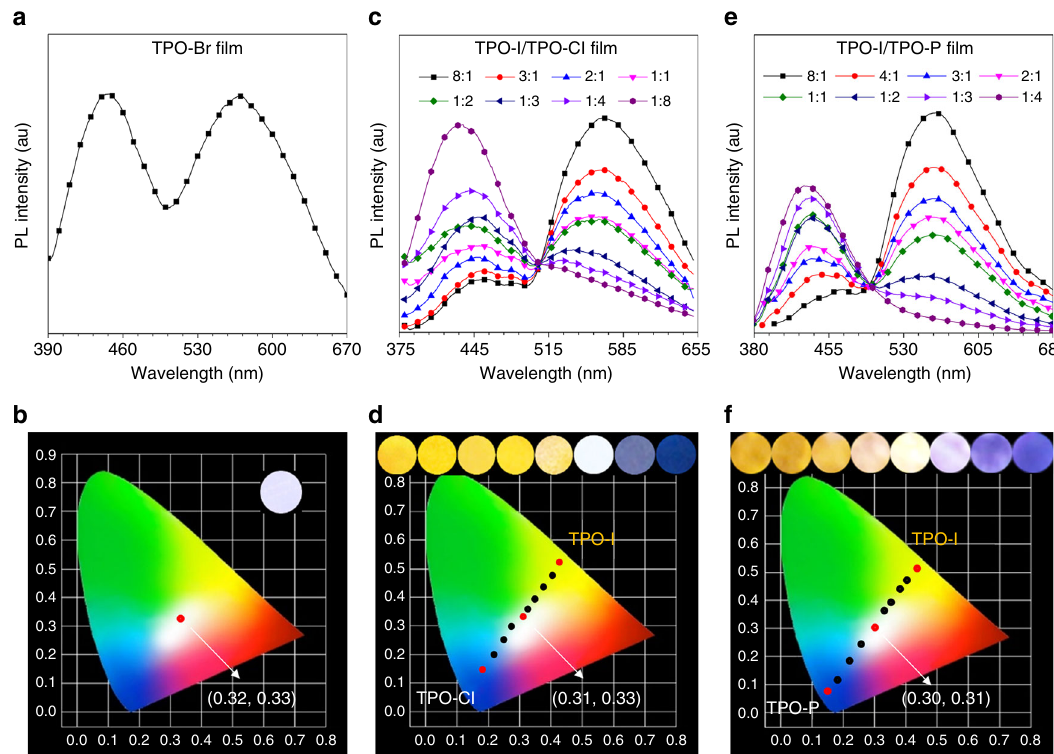
Fig. 4 OSMWLEs constructed by organic salts. a TPO-Br only, c TPO-I/TPO-Cl and e TPO-I/TPO-P with different counterions molar ratios. Commission Internationale de L ’ Eclairage (CIE) 1931 coordinates of prompt emission of fi lms: b TPO-Br only, d TPO-I/TPO-Cl and f TPO-I/TPO-P with different molar ratios. Insets show luminescent photographs of these thin fi lms taken under 365 nm UV